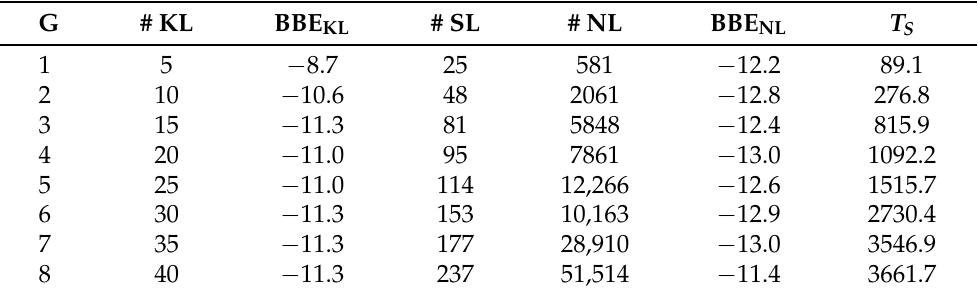
Table 5. The number of known ligands (# KL), the best binding energy (BBE KL ) of known ligands, the number of fragments (# SL), the number of new ligands (# NL), the best binding energy (BBE NL ) of new ligands and the computational time ( T S ) in minutes for each group with the semi-exhaustive approach.